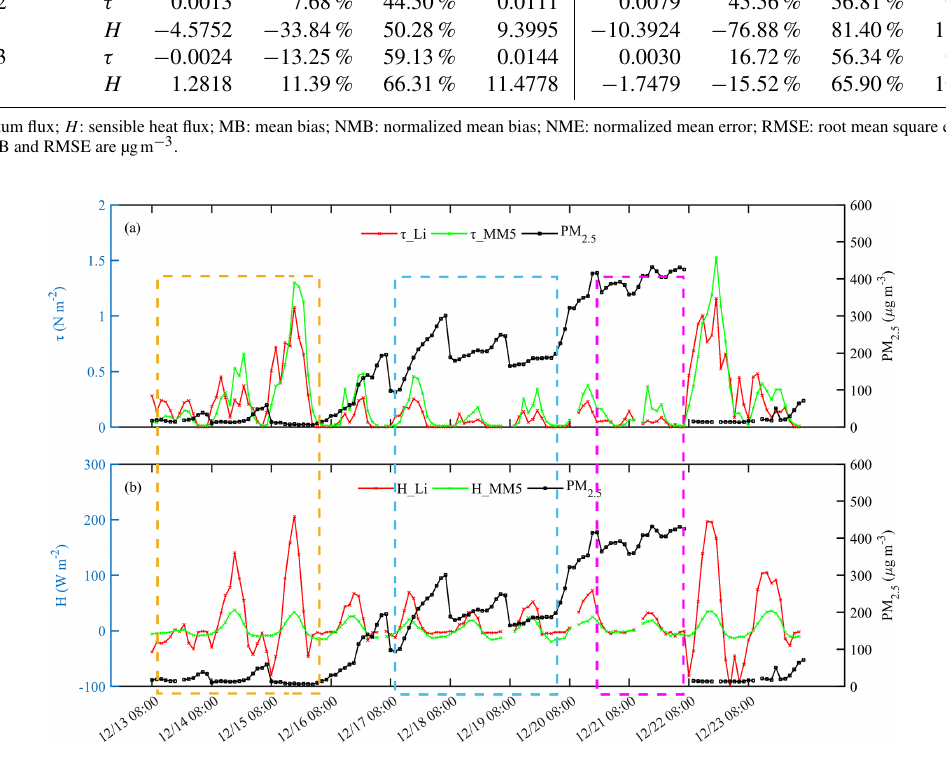
Figure 9. As in Fig. 7 but for Beijing